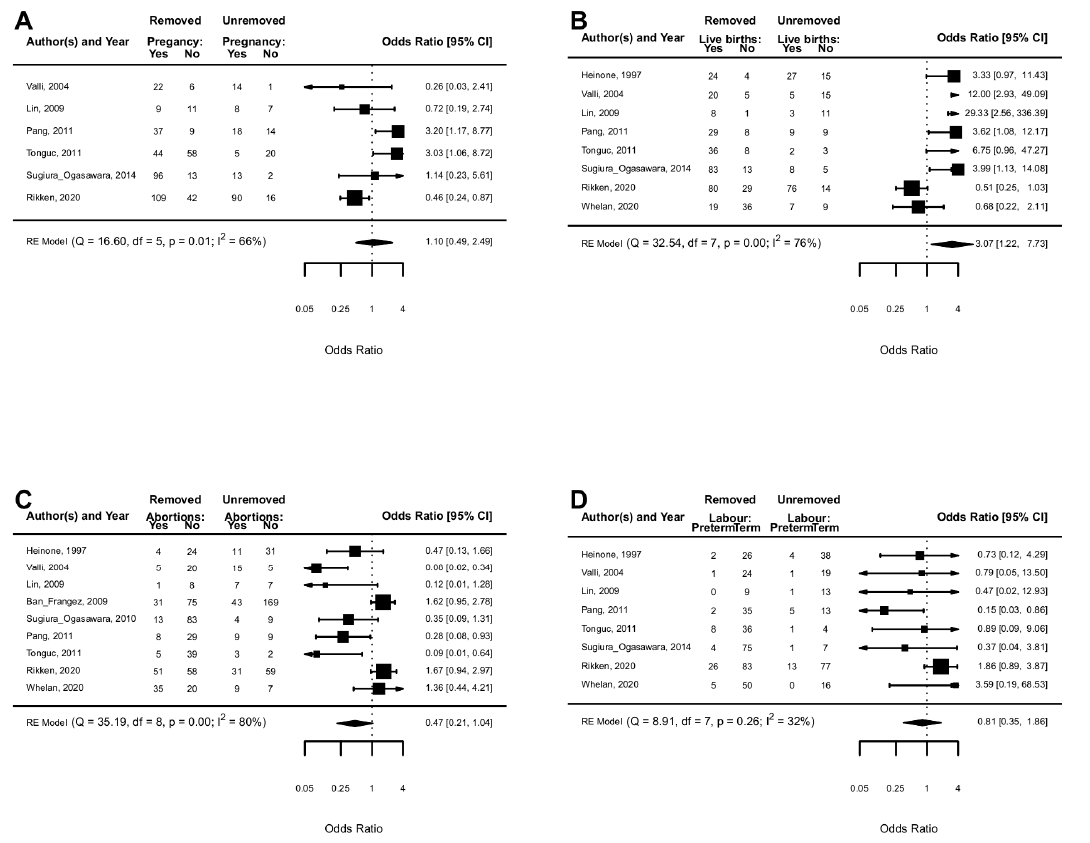
Figure 3. Treated uterine septum vs untreated uterine septum: clinical pregnancy rate ( A ), live birth rate ( B ), spontaneous abortions in I-II trimesters ( C ), and preterm labour ( D ).